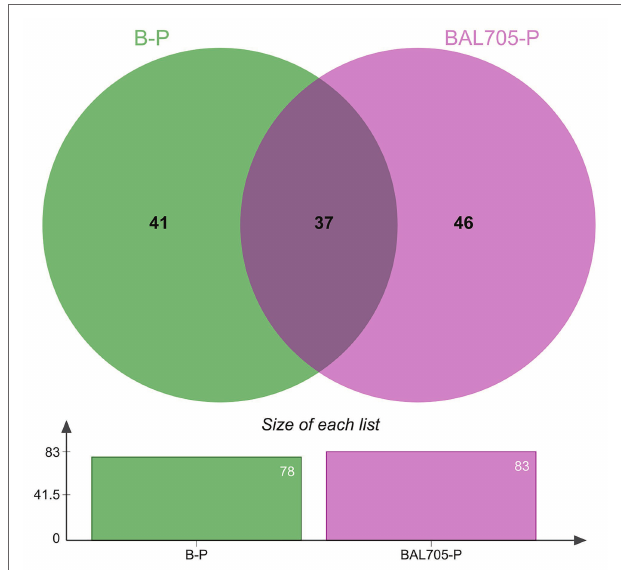
FIGURE 1 | Venn diagram of the distribution of unique and shared differentially expressed proteins identified in biofilms formed by L. monocytogenes in the absence (B-P) and presence of lactocin AL705 (BAL705-P) at 10 ° C in comparison to planktonic cells grown at 10 ° C without